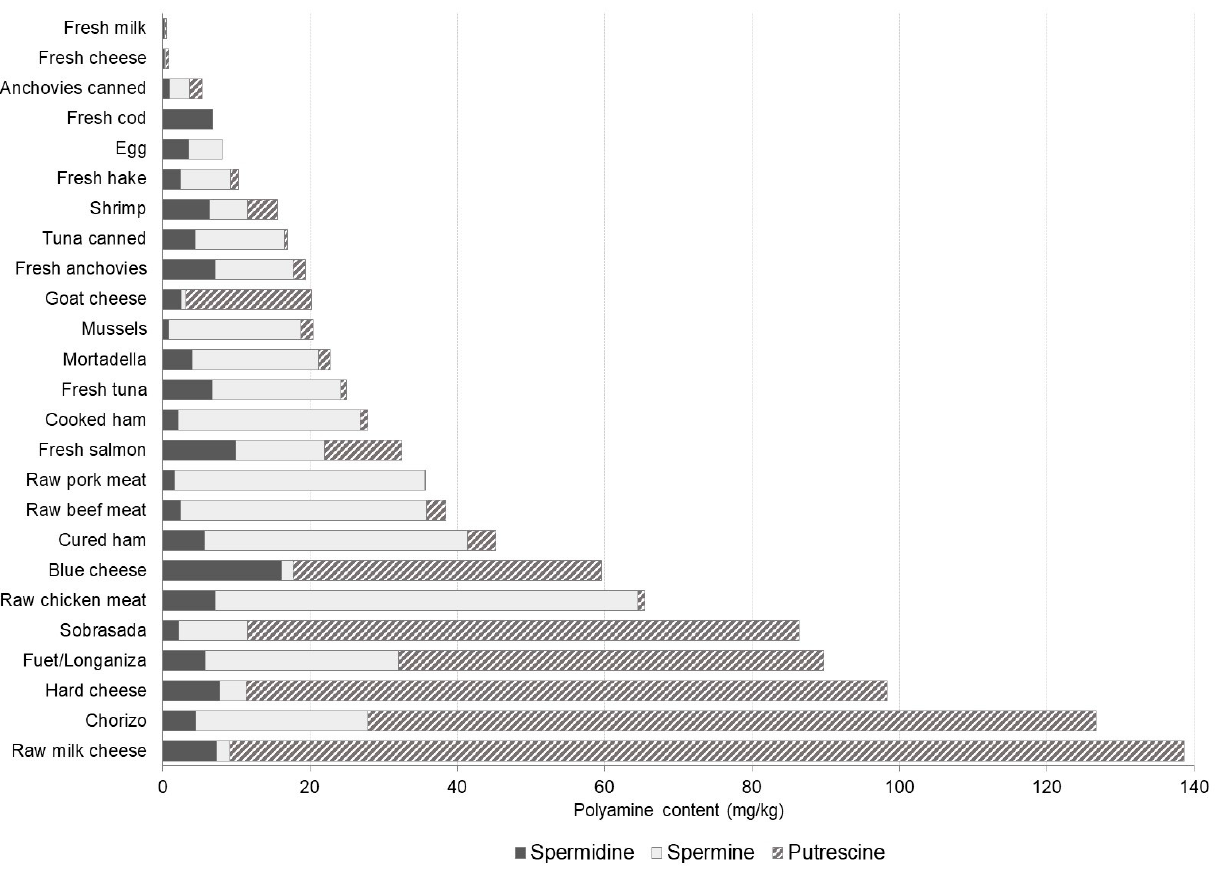
Figure 6. Polyamine profile and content (mg/kg) in meat, fish and dairy products.